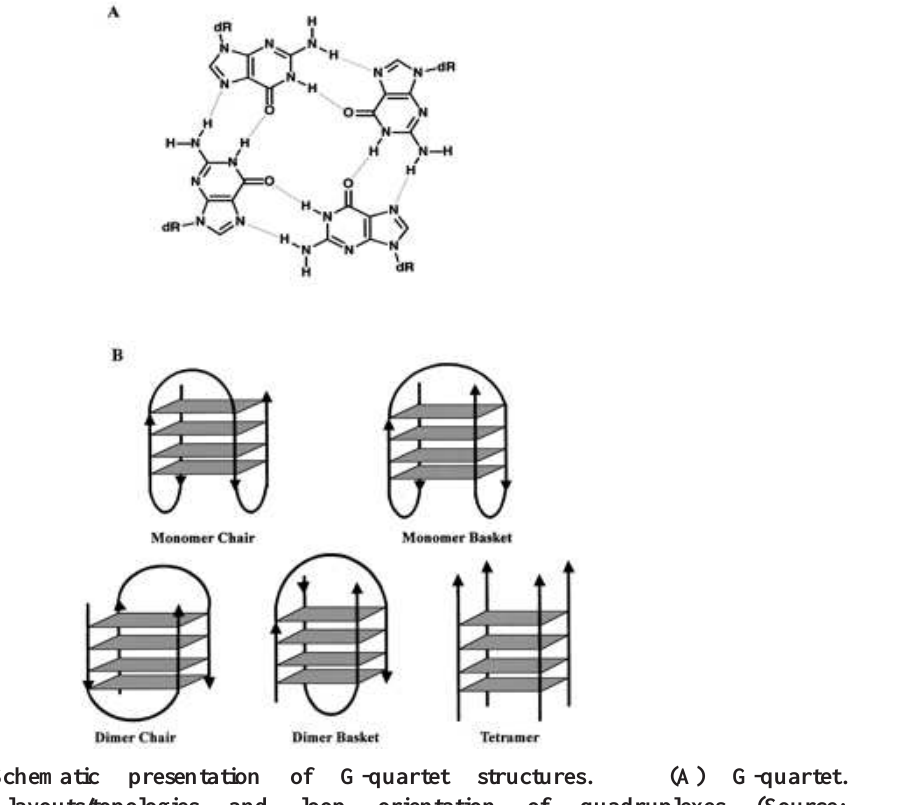
Figure 1: Schematic presentation of G-quartet structures. (A) G-quartet. (B) Different layouts/topologies and loop orientation of quadruplexes (Source: